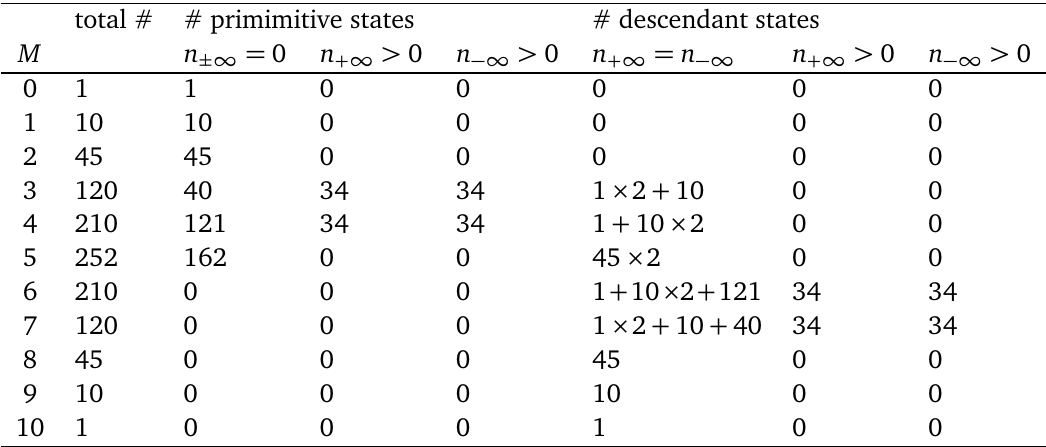
Table 1: The full spectrum for N = 10, ∆ = 1 in terms of primitive and descendant states with n + ∞ = n −∞ , n + ∞ > n −∞ = 0, n −∞ > n + ∞ =